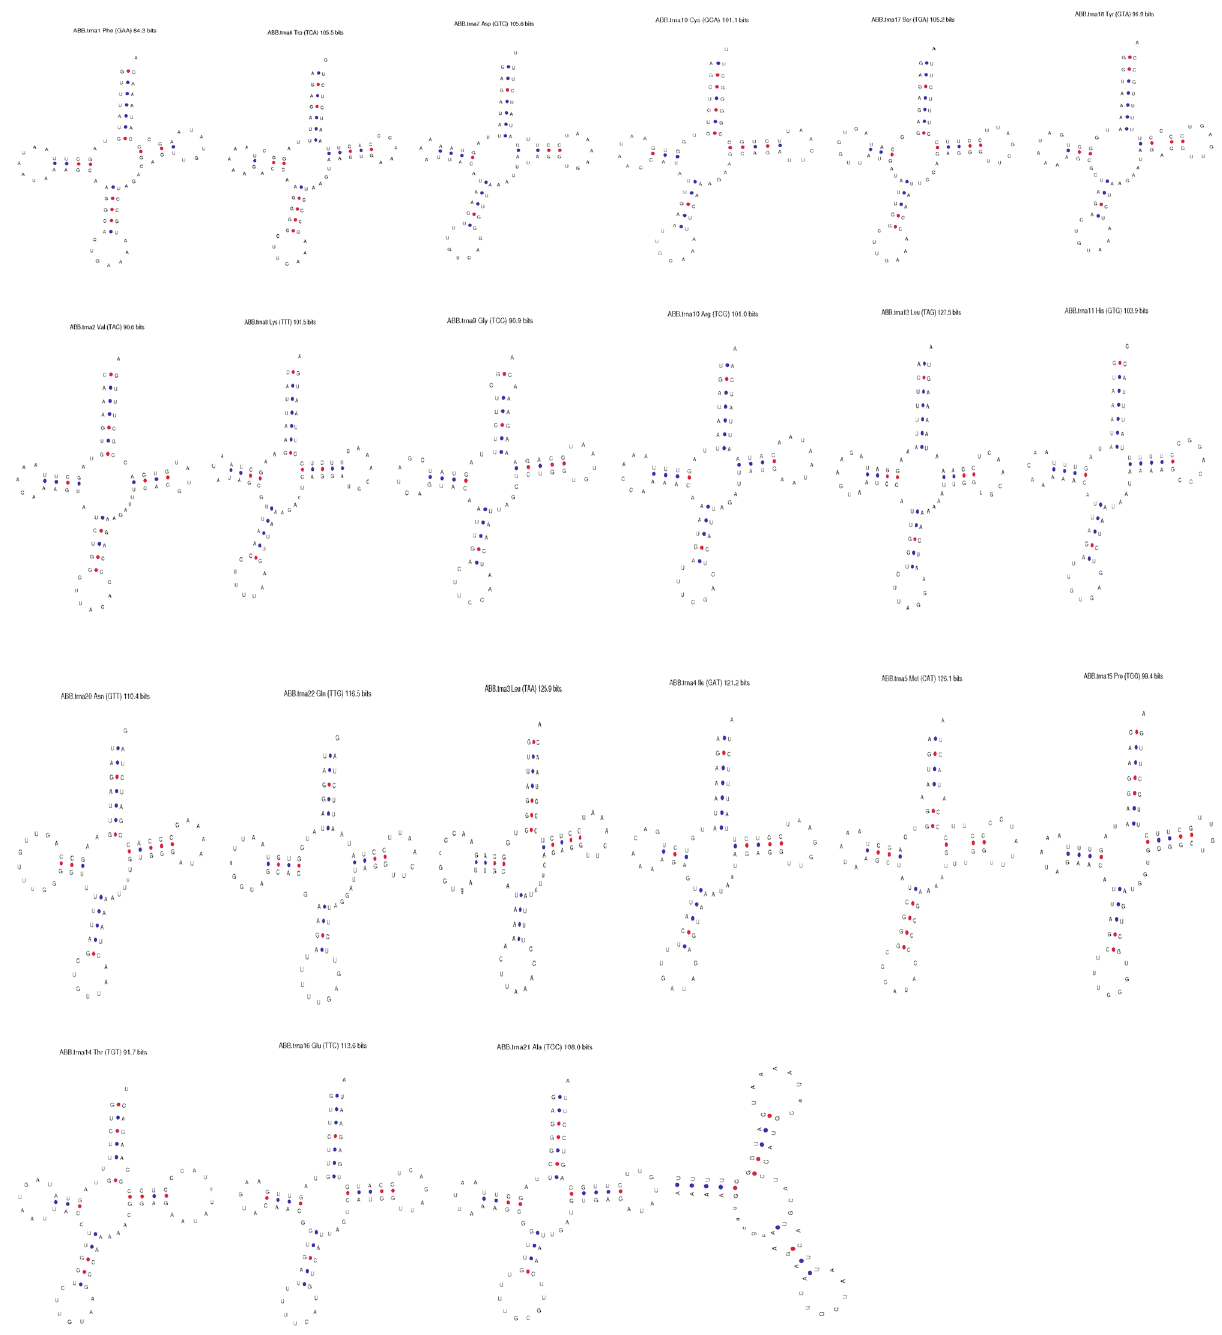
Figure 3. Putative secondary structures of 22 transfer RNA genes of Ursus thibetanus linager where the red dots indicated Watson–crick pairing and the blue dots indicated other non-Watson–Crick